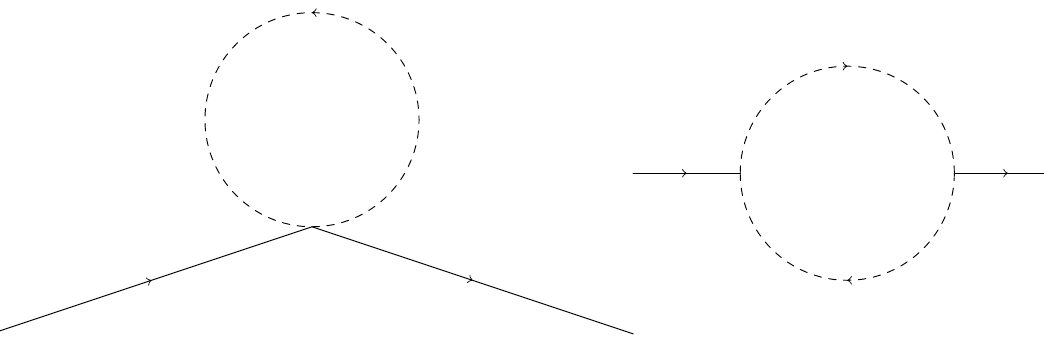
Figure 1 . The one-loop contributions to the polarization operator. The dashed lines correspond to the scalar (cid:12)eld. The solid ones are photon